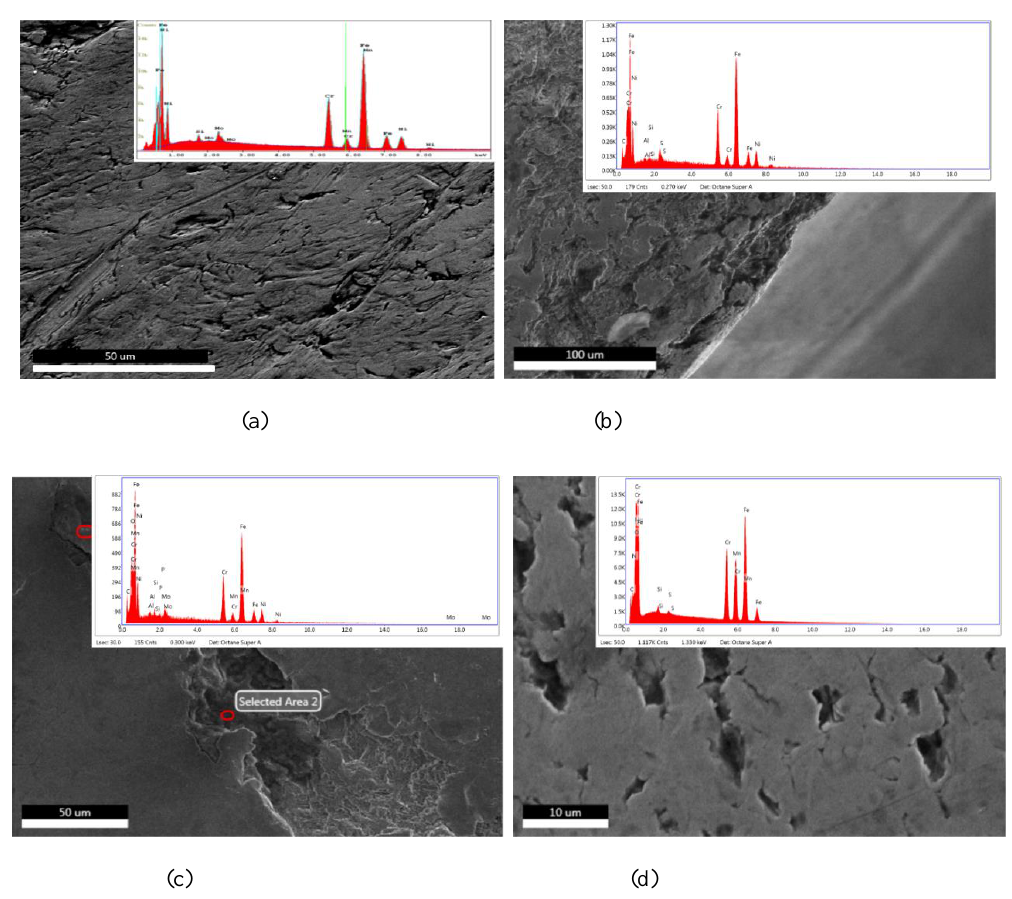
Figure A1. Energy-dispersive X-ray analysis shows the peaks of different element weight percent in ( a ) the plate, ( b ) cortical screw, ( c ) locking screw, and ( d ) cannulated screw.